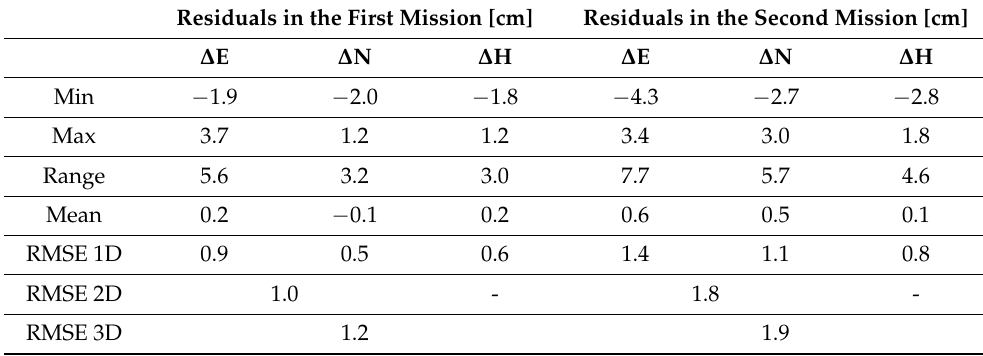
Table 6. Statistics of residuals between determined and referent displacement vectors values and RMSE of determining displacements with the proposed data processing method. Residuals in the First Mission [cm] Residuals in the Second Mission [cm] ∆